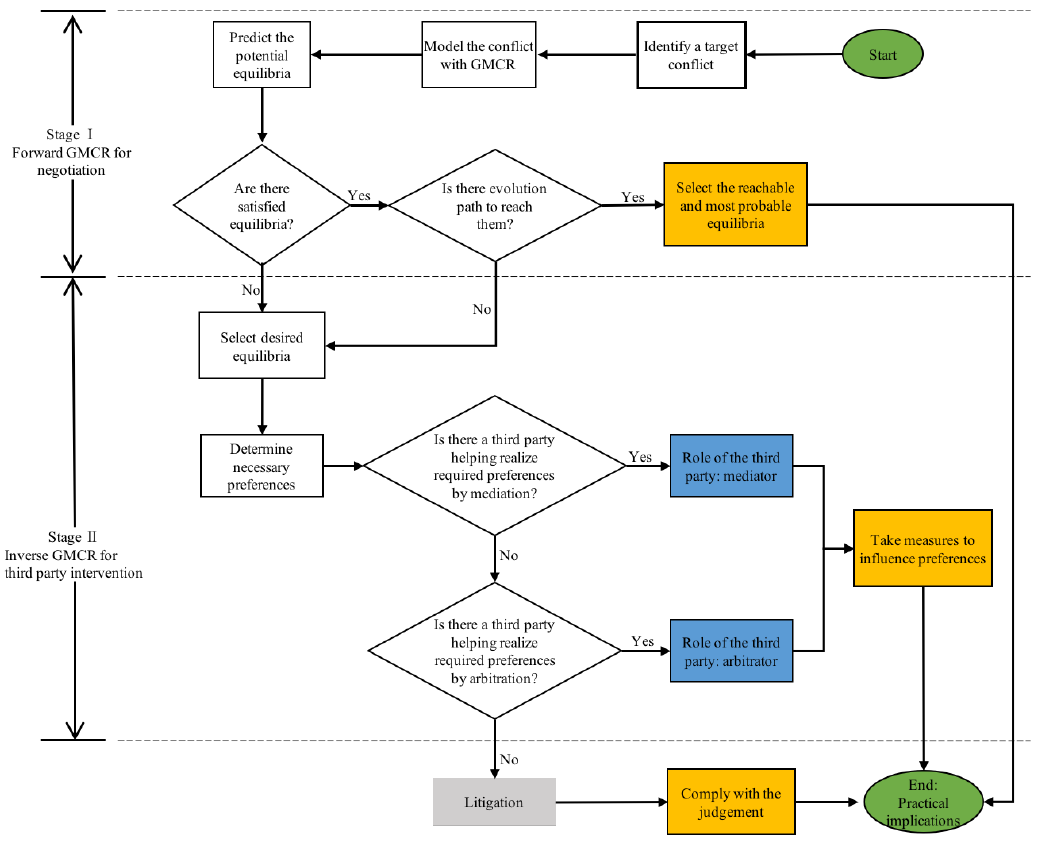
Figure 5. A decision making framework for Brownfield Conflict (BC)